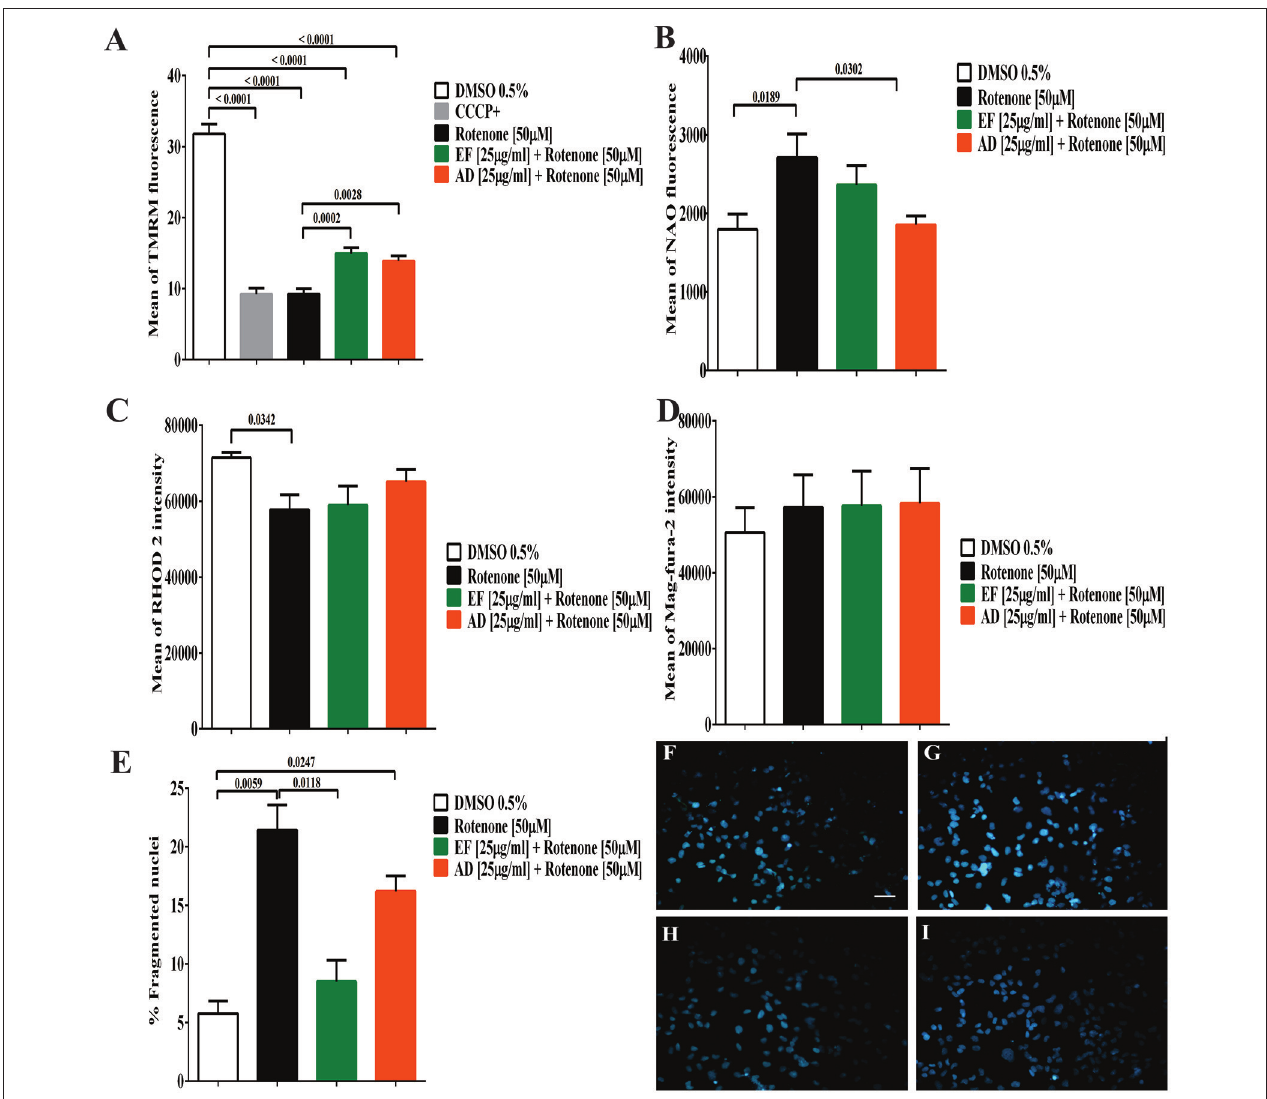
FIGURE 3 | Determination of mitochondrial parameters, the content of cellular calcium and cell morphology. (A) Mean TMRM fluorescence in T98G cells. Determination of mitochondrial membrane potential by flow cytometry in T98G cell cultures after co-treatment with 50 µ M rotenone plus EF and AD at 25 µ g/ml. (B) Mean fluorescence of NAO in T98G cells by flow cytometry in T98G cell cultures after co-treatment with 50 µ M rotenone plus EF and AD at 25 µ g/ml. (C) Determination of mitochondrial calcium concentration in T98G cells. Mean fluorescence of RHOD 2, mitochondrial calcium indicator, in T98G cell cultures after co-treatment with 50 µ M rotenone plus EF and AD at 25 µ g/ml. (D) Determination of endoplasmic calcium concentration in T98G cells. Mean fluorescence of Mag-fura-2 fluorometer, calcium indicator in cytoplasmic reticulum in cell cultures of T98G after co-treatment with 50 µ M rotenone plus EF or AD at 25 µ g/ml. (E) Percentage of cells with fragmented/condensed nuclei in T98G cells, measured by Hoescht staining after treatment with 50 µ M rotenone and co-treatment with extracts EF and AD at 25 µ g/ml. Determination of Hoescht by fluorescence microscopy in (F) Cells exposed to 0.5% DMSO, (G) Cells damaged with 50 µ M rotenone ( p = 0.0059), (H) Cells co-treated with 50 µ M rotenone plus EF 25 µ g/ml, (I) Cells co-treated with 50 µ M rotenone and 25 µ g/ml AD ( p = 0.0247). Bar scales: 10 µ